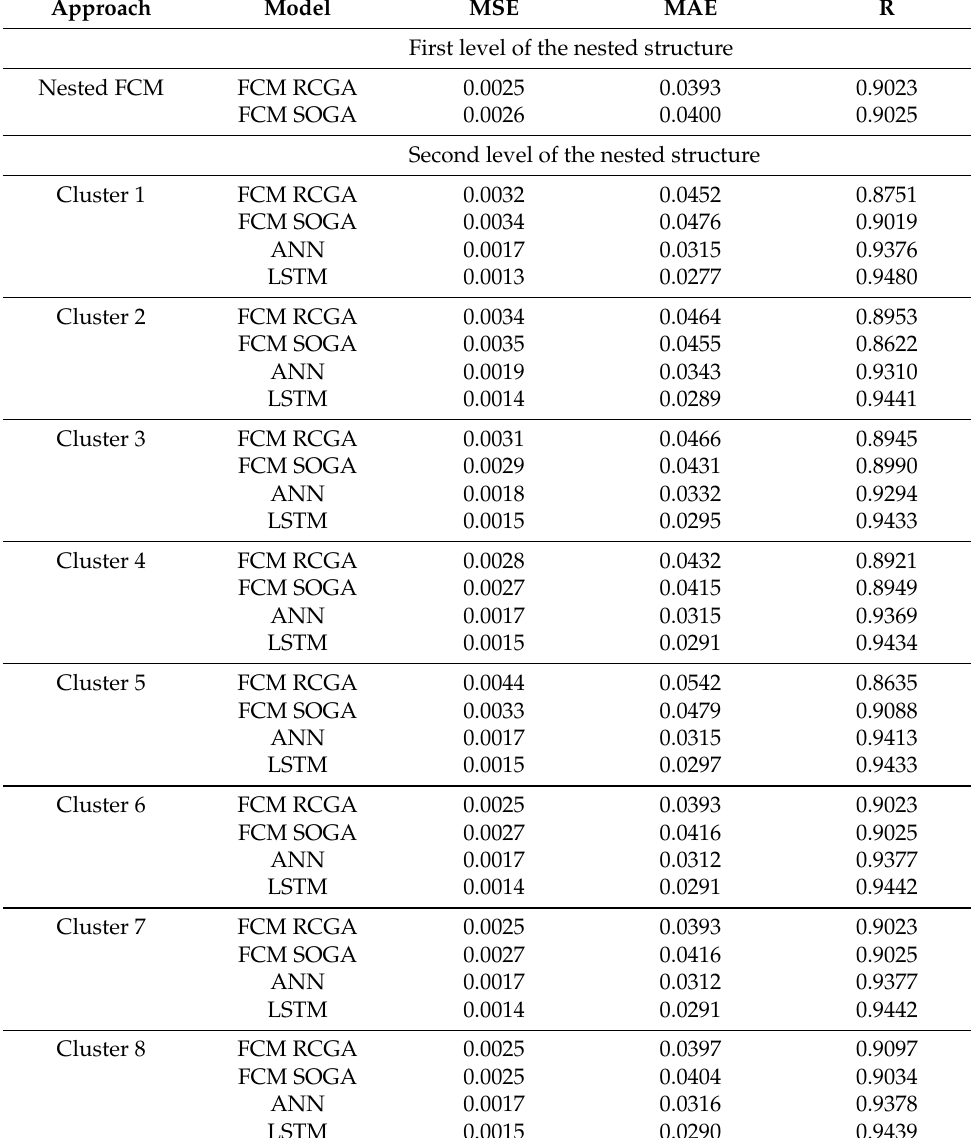
Table 2. Results for the nested fuzzy cognitive